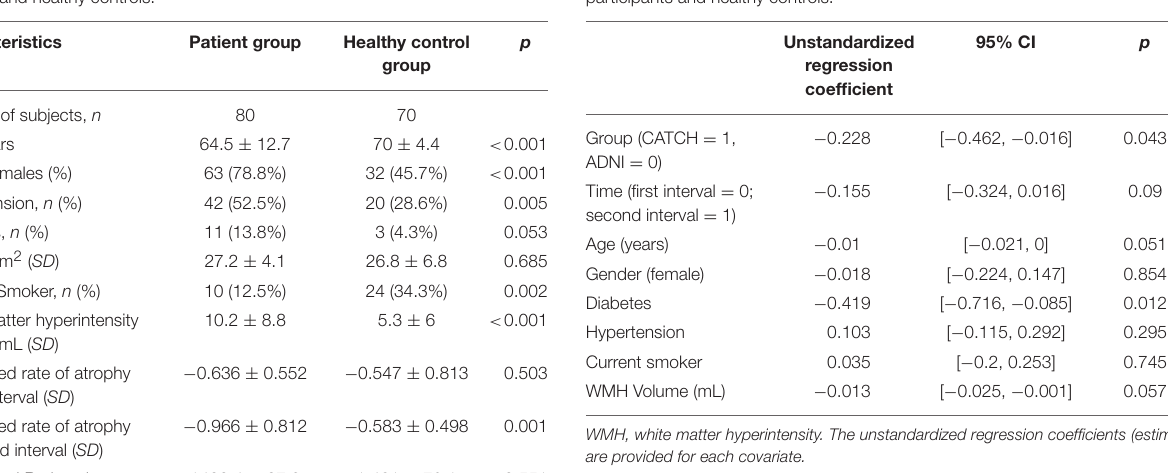
TABLE 2 | Annualized whole brain atrophy rate of TIA and minor ischemic stroke participants and healthy controls. Unstandardized regression coefficient